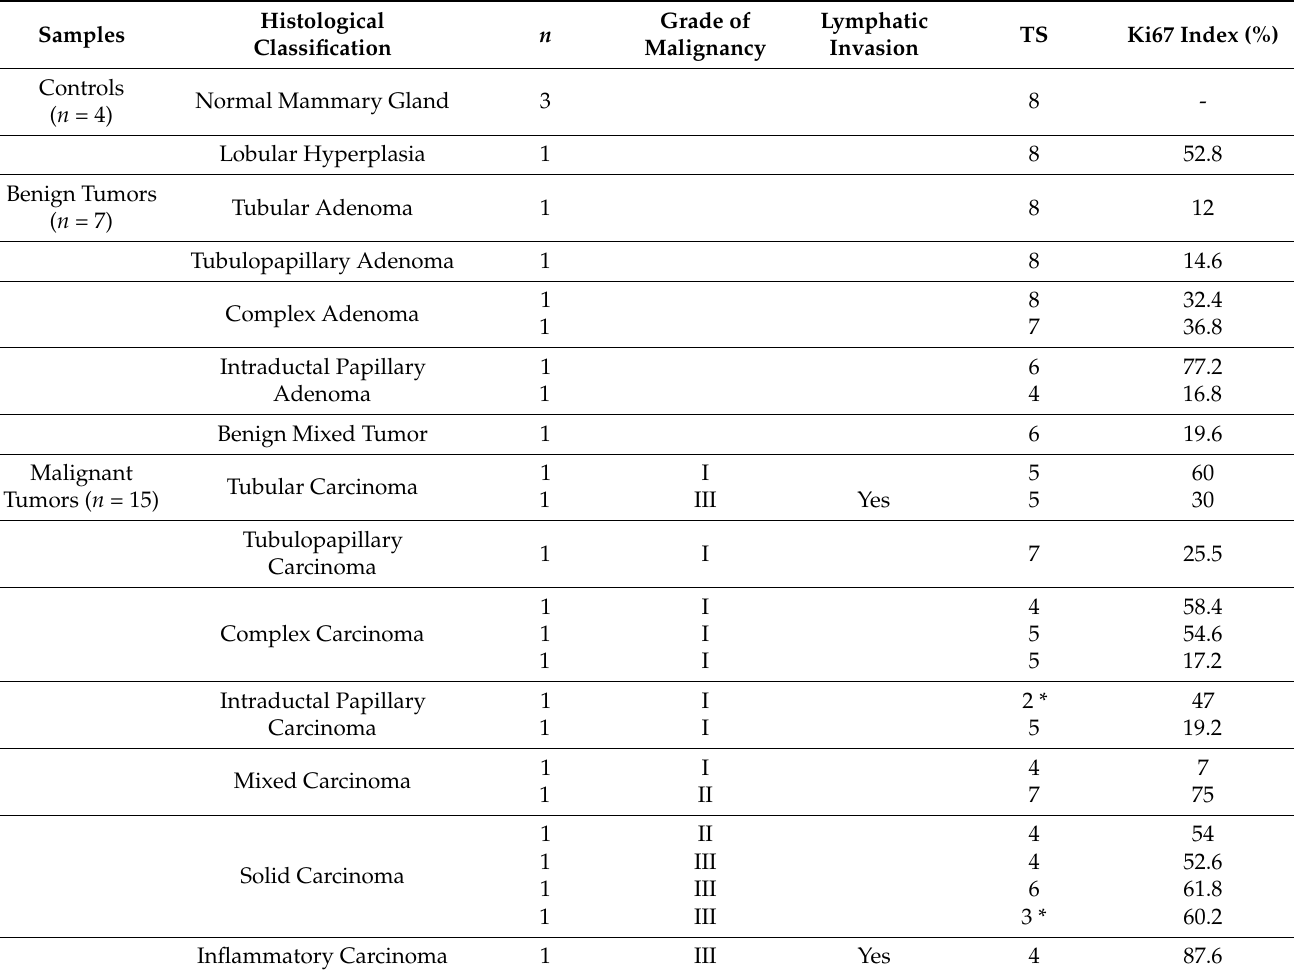
Table 3. Histological classification, Allred Score and Ki67 indexes for canine mammary samples. TS = total score. * ER-negative tumors